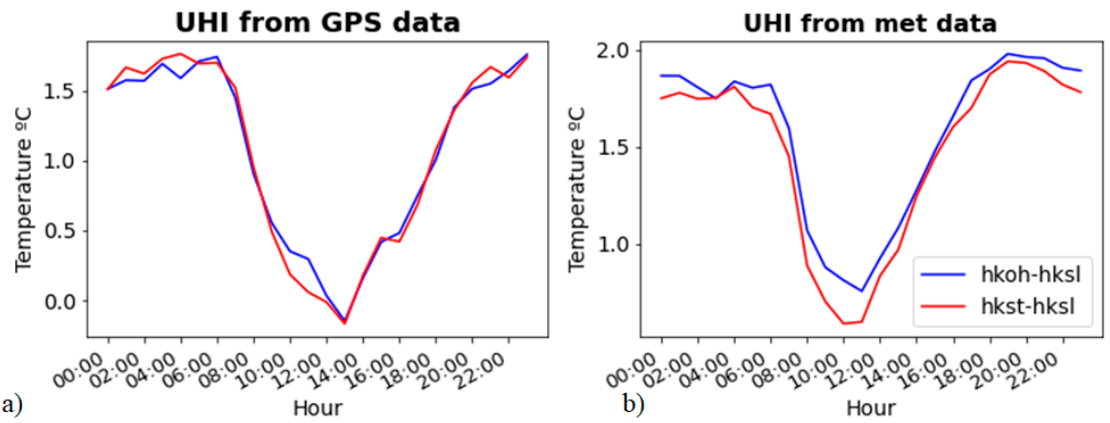
Figure 3. Diurnal cycle of AUHI intensity in Hong Kong with ( a ) GPS data and ( b ) meteorological data.